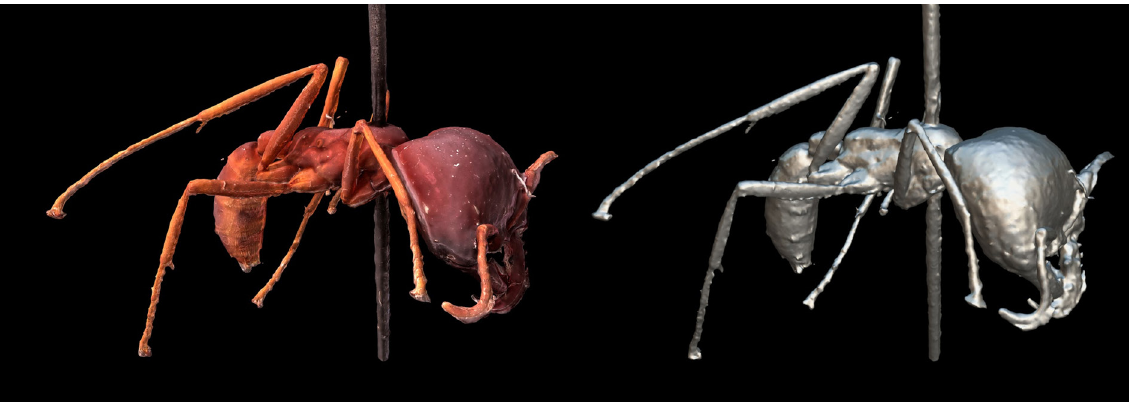
Fig. 3.20. 3D model of a Dorylus ant (size: 1.5 cm) based upon focus stacked images, textured model is on the left, the view of only the mesh is on the right. The VCM option in Agisoft Photoscan is chosen to include small detail in the 3D model. The tibia spurs are clearly marked.